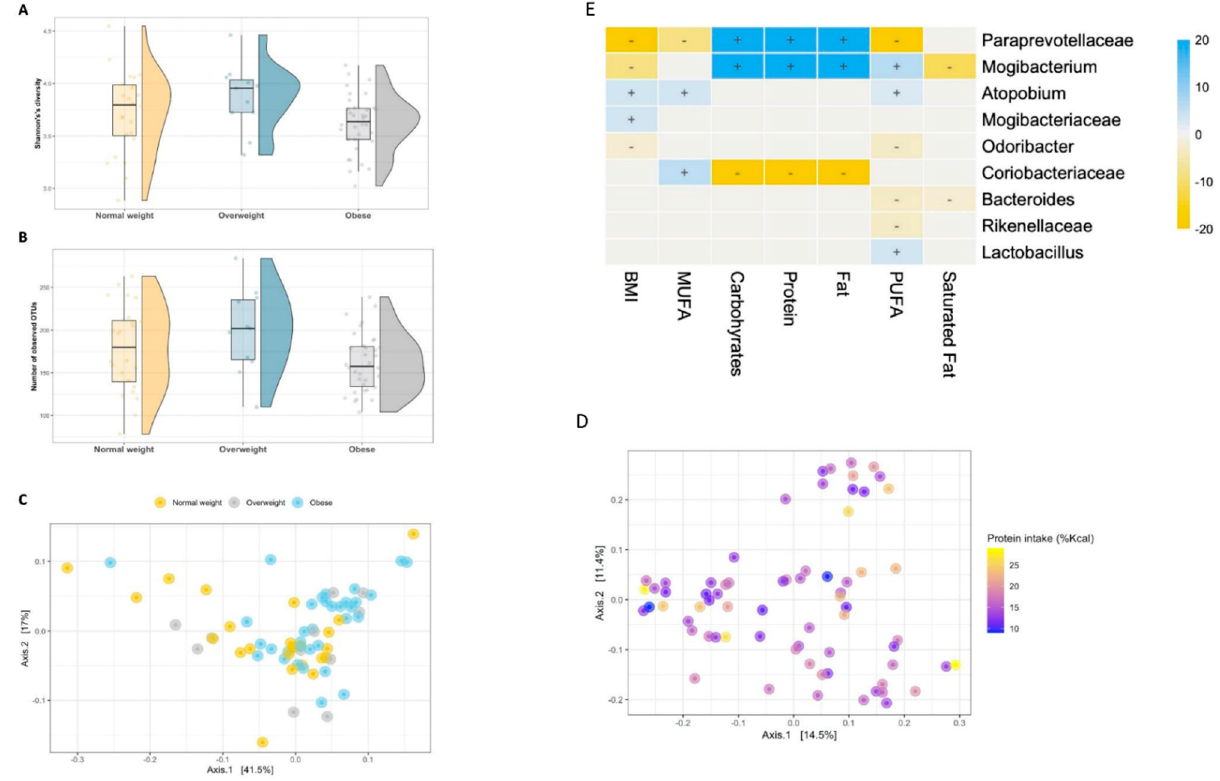
Figure 3. Low socioeconomic status and the intestinal microbiome. Box plots of alpha diversity according to BMIZ score categories. ( A ) Alpha diversity was measured by the Shannon’s diversity index, and ( B ) richness. ( C ) Principal component analysis (PcoA) of the weighted UniFrac showing a significant separation of the BMIZ score categories and ( D ) intake of protein measured by the unweighted UniFrac distance. ( E ) A heatmap of the multivariable model describing the top associations between the independent variables and bacterial features. Positive associations are colored in blue, while inverse associations are colored in yellow. The color gradient represents the strength of the association, with darker colors representing stronger associations. The effect size was calculated by the following formula: ( − log(qval)*SIGN